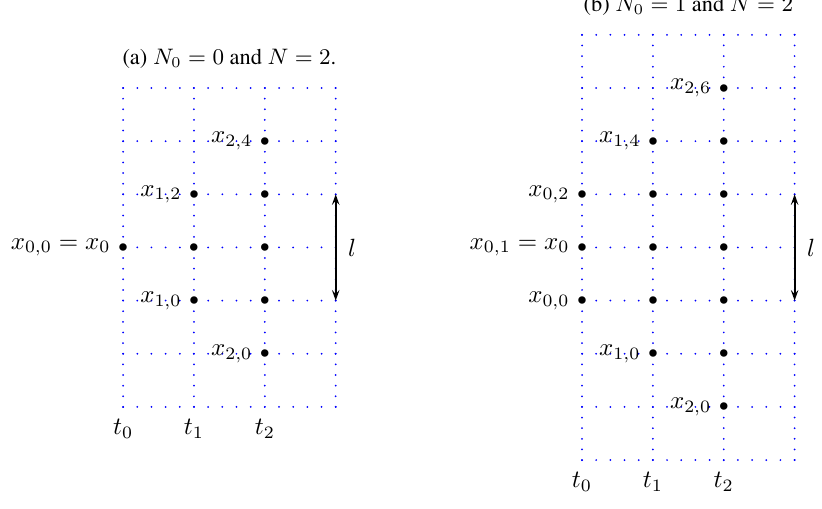
Figure 1. Examples of alternative